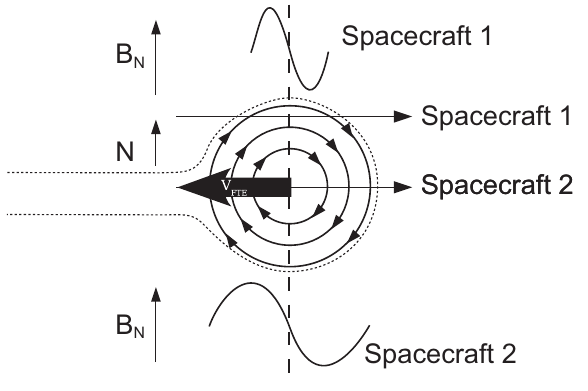
Fig. 4. An illustration of the B N signature observed by two space- craft intersecting an FTE at different positions. An assumption made in the multi-spacecraft timing analysis is that the delay be- tween the observed signatures at each spacecraft is due to the pas- sage of a planar surface. In this figure, spacecraft 1 observes a briefer signature than spacecraft 2, but the planar surface perpen- dicular to the direction of motion is that which passes through the mid-points of the B N signature (central dashed line). The plane is independent of any model of FTE structure. In this figure, a Russell and Elphic (1978) flux tube is indicated by solid circular field lines, whereas a Southwood et al. (1988) model FTE is indicated by the dotted